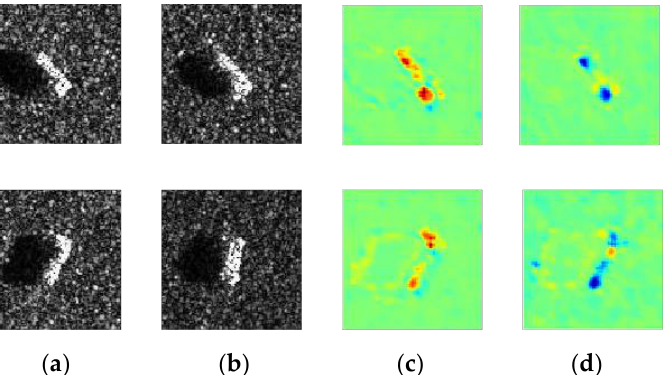
Figure 8. Comparison of different classes of heatmaps in the same SAR image. ( a ) SAR images of class 6. ( b ) SAR images of class 5. ( c ) SAR images of class 6 corresponding to heatmaps of class 6. ( d ) SAR images of class 6 corresponding to heatmaps of class 5.